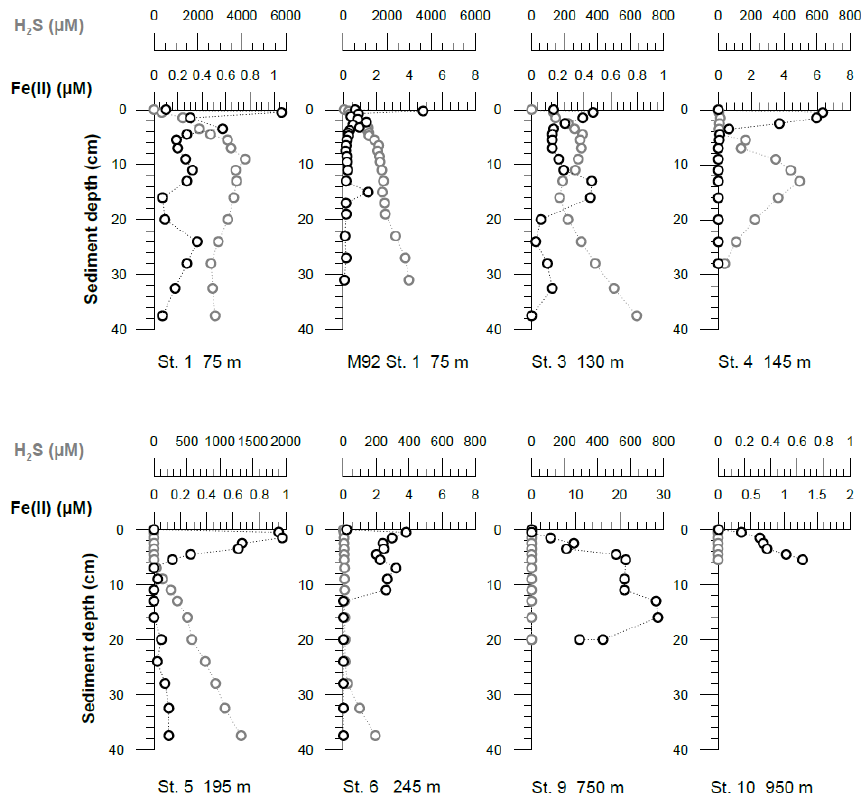
Figure 4. Pore water dissolved Fe(II) and hydrogen sulfide concentrations. Data from an earlier cruise, M92, at Station 1 (75m water depth) are displayed for comparison. The uppermost sample represents the bottom water concentration. The analytical error is smaller than the symbol